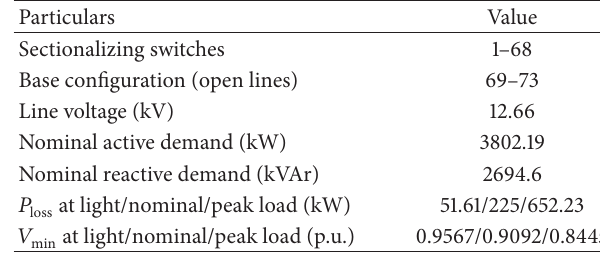
Table 1: Initial data of 69-bus system.